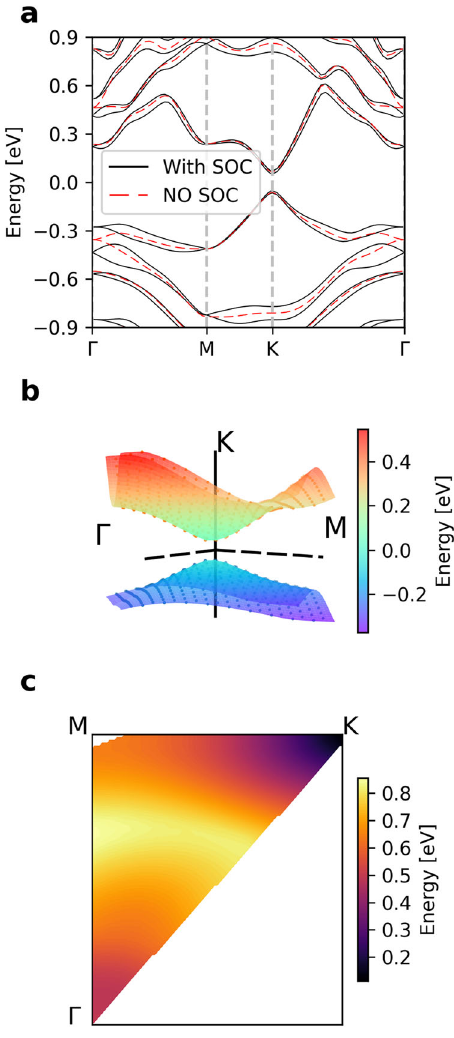
Fig. 2 Electronic band structure and heathmap. a Free-standing GeSn bilayer with (black) and without (red) SOI. b 3D plot of the lowest unoccupied band (red) and of the highest occupied band (blue) calculated in proximity of the point K. c Heatmap of the electronic energy gap calculated in the